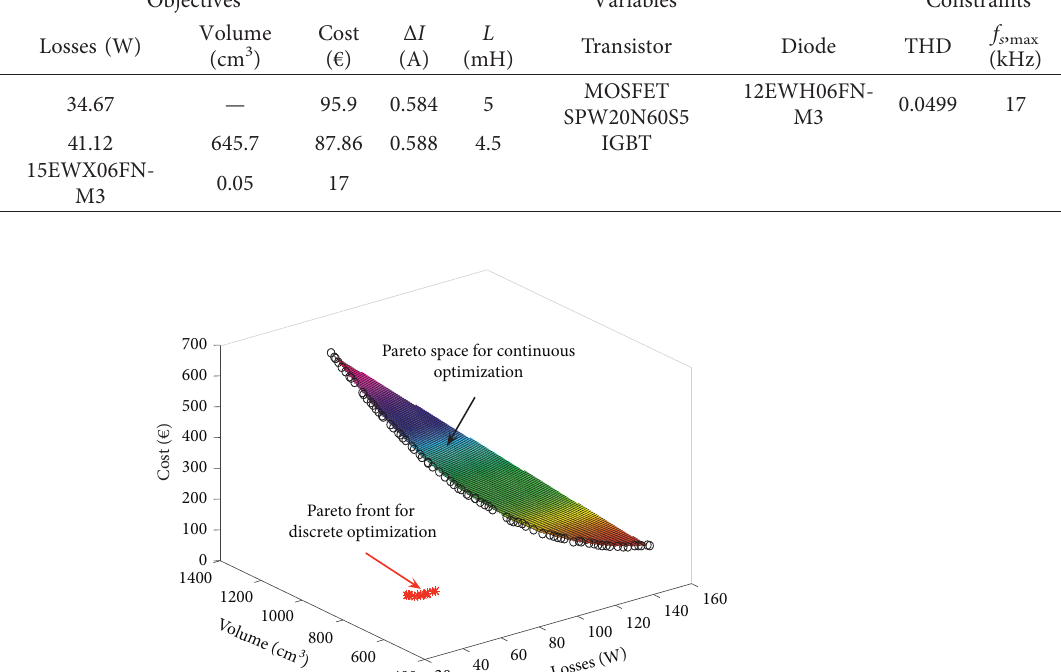
Figure 9: Comparing the Pareto front for discrete triobjective optimization problem to the Pareto space for a continuous